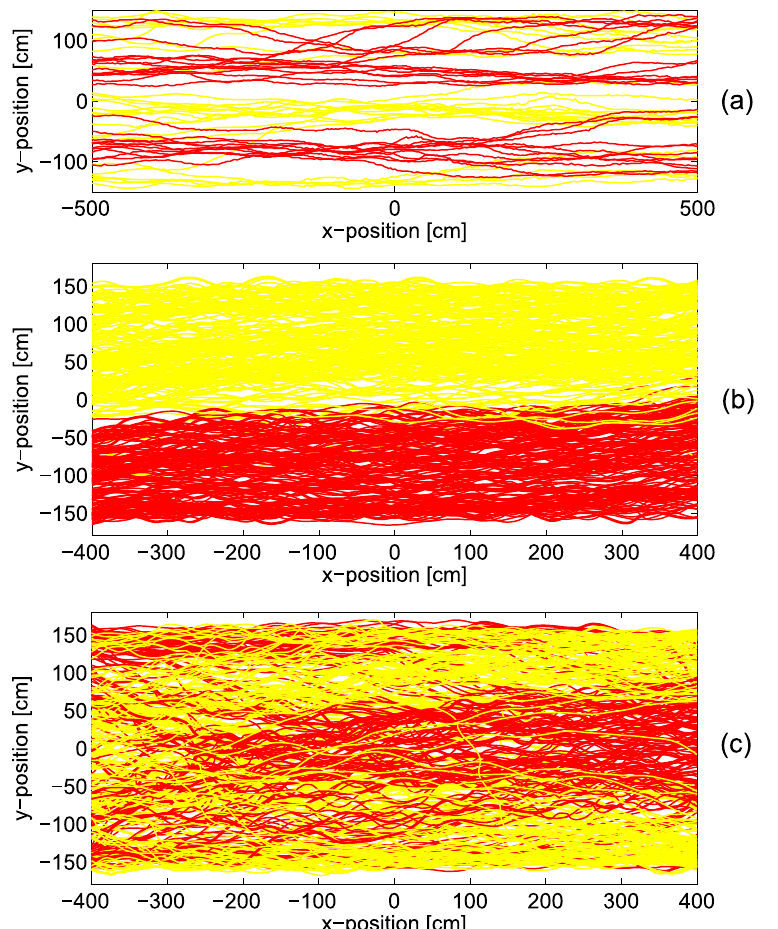
Fig 4. Bidirectional flow trajectories. Example of trajectories from some of the cases considered in the three groups. For each case several repetitions were performed and the example provided here is relative to only one execution; all are relative to the balanced configuration. Also, total time considered for plotting trajectories is different, so the number of lines is not relative to the density of pedestrians. Yellow trajectories are relative to left to right walkers, red to the opposite